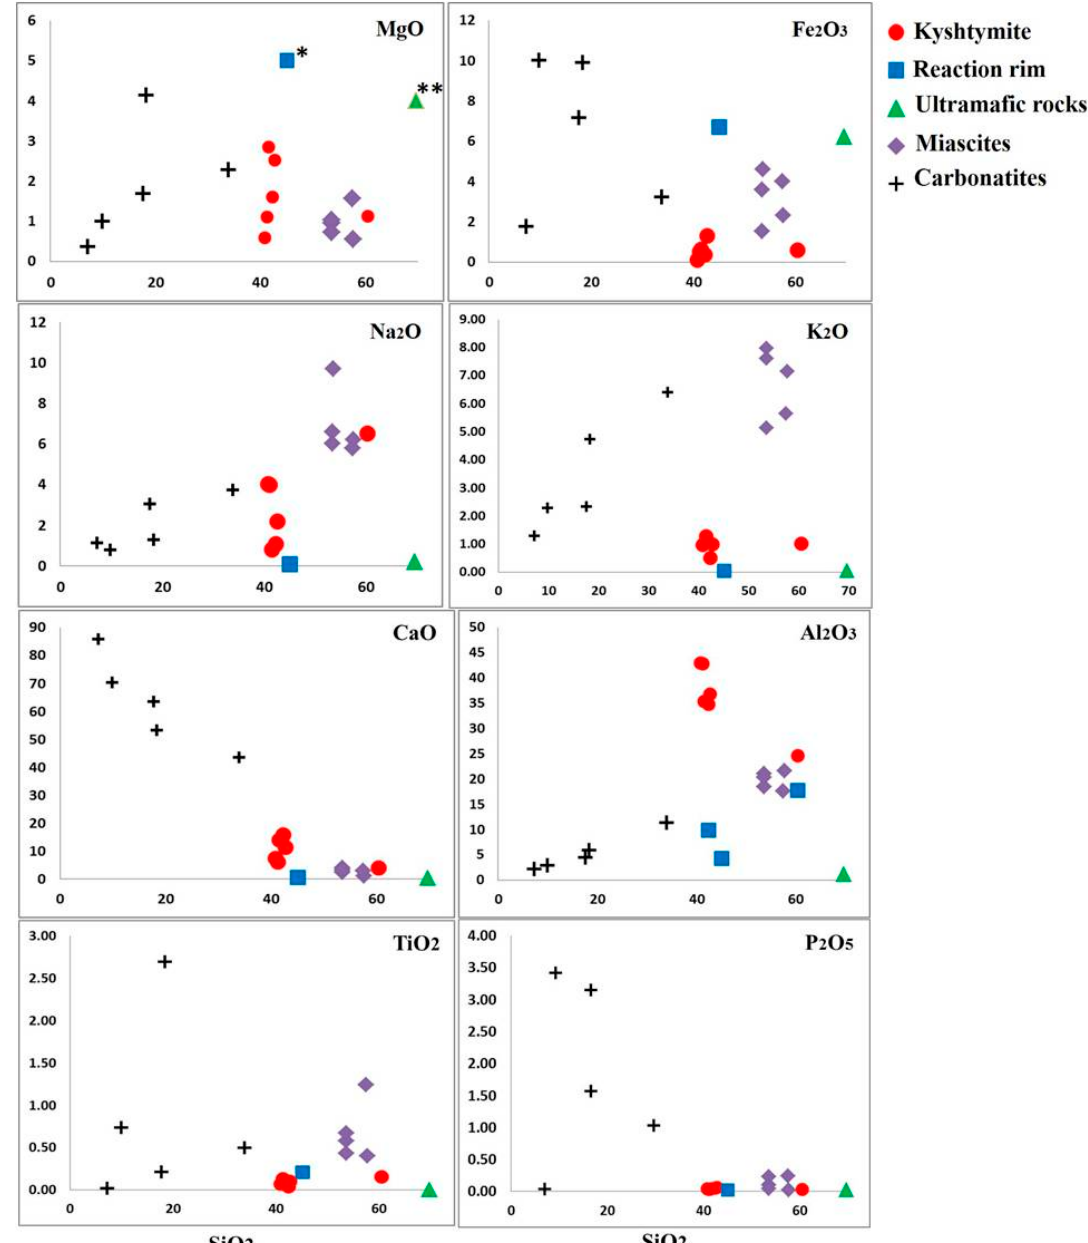
Figure 12. Harker diagrams for analyzed kyshtymites, reaction rim (* MgO, 28.08 wt. %) between kyshymites and meta-ultramafic host rocks, meta-ultramafic host rocks (** MgO, 17.97 wt. %), miascites, and carbonatites of Vishnevogorsky complex (chemistry of miascites and carbonatites is modified after Nedosekova et al. (2009) [18].